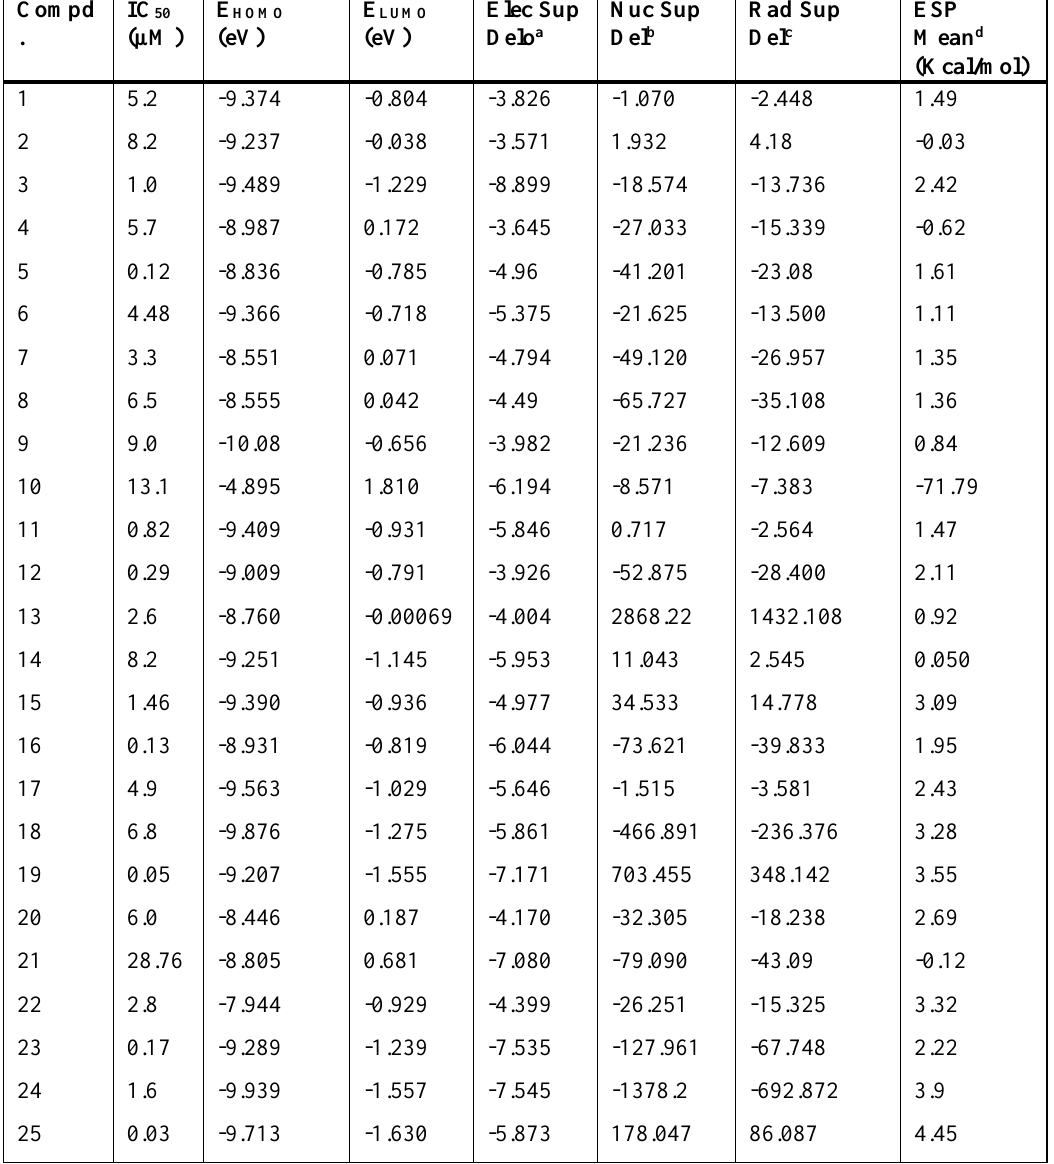
Table S3. Quantum chemical parameters of Mt AlaR inhibitors 1-25